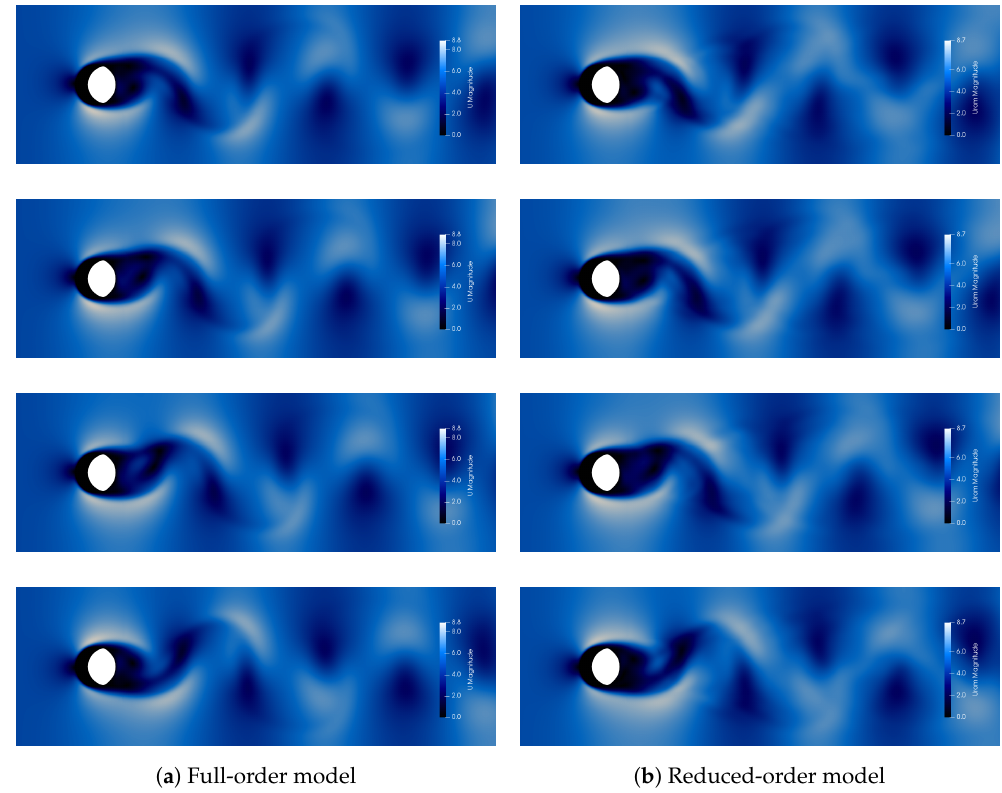
Figure 6. Incompressible flow past a cylinder placed in a channel at a right angle to the oncoming fluid. The simulation was carried out in OpenFOAM, with Reynolds number set to 161. Comparison of velocity U between the full-order model ( a ) and the reduced-order model solutions ( b ).